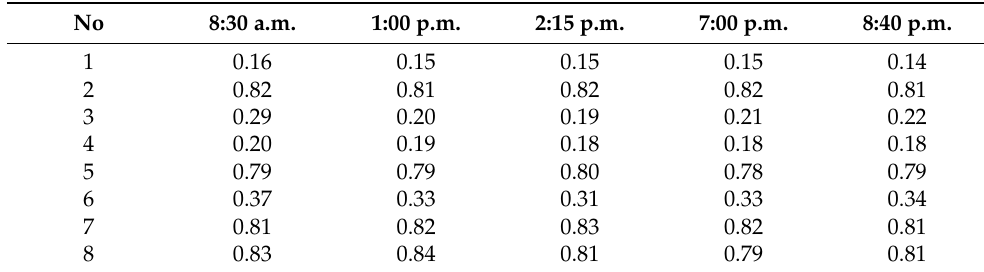
Table 7. NDVI values measured on the study points by a handheld spectrometer at 5 different